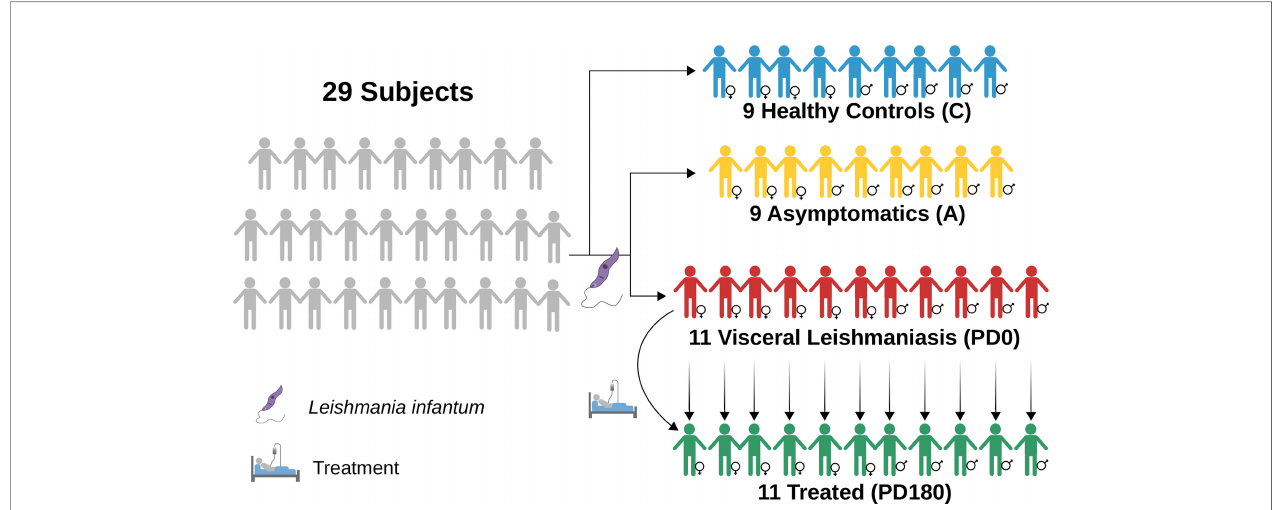
FIGURE 1 | Diagram depicting the groups used in this work to perform RNA-seq data analyses of blood transcriptomes from VL patients (PD0, in red) compared to nondiseased groups, treated (PD180 in green, cured patients), asymptomatic subjects IgG + for Leishmania infantum (A, in yellow) and healthy/control subjects (C, in blue). Image diagrammed in Inkscape (https://inkscape.org/).